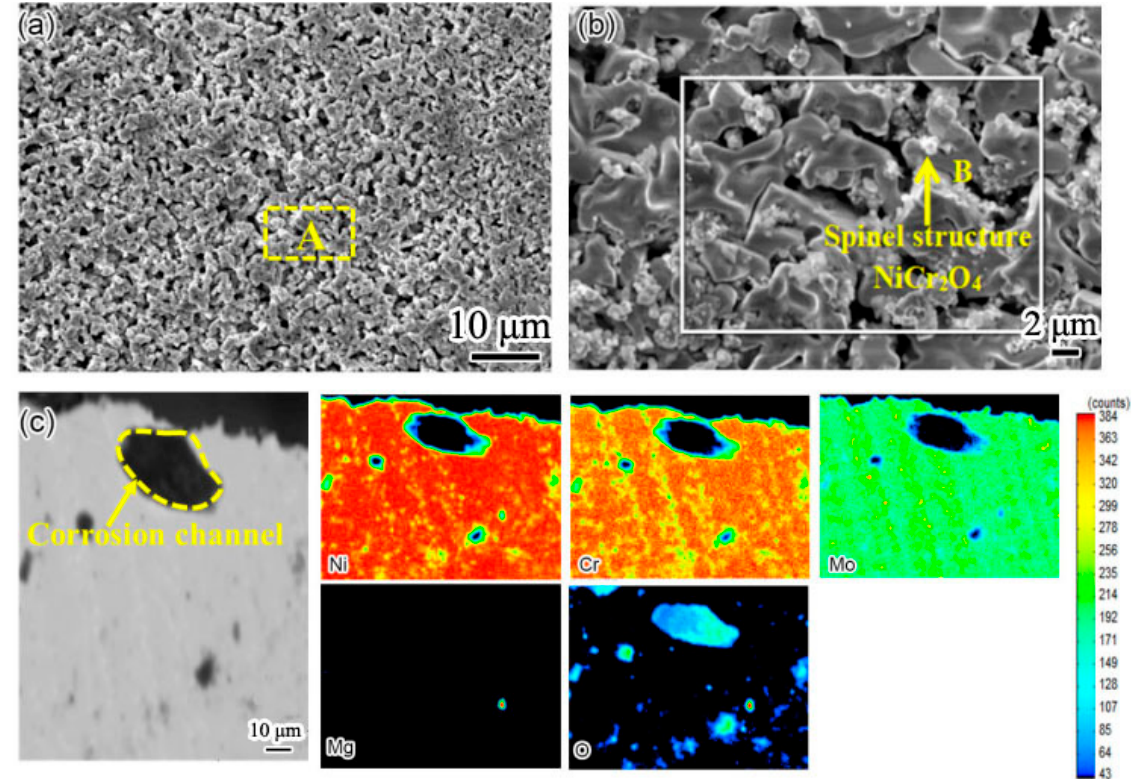
Figure 10. Surface and cross-sectional morphology of the Inconel 625 weld cladding after corrosion for 10 h. ( a ) SEM surface morphology. ( b ) High magnification of area A. ( c ) EPMA section morphology and corresponding elemental maps. Table 5. Surface element content of the Inconel 625 weld cladding after corrosion for 10 h.